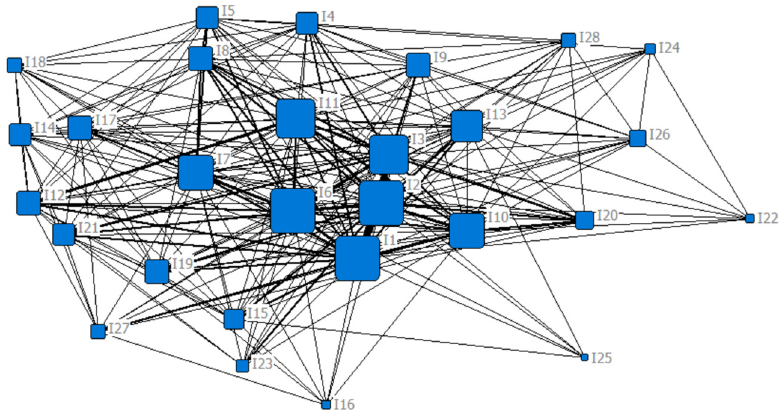
Figure 4. The social network of the influencing factors of Chinese urban community function loss under the flood disaster with the added betweenness centrality attribute.